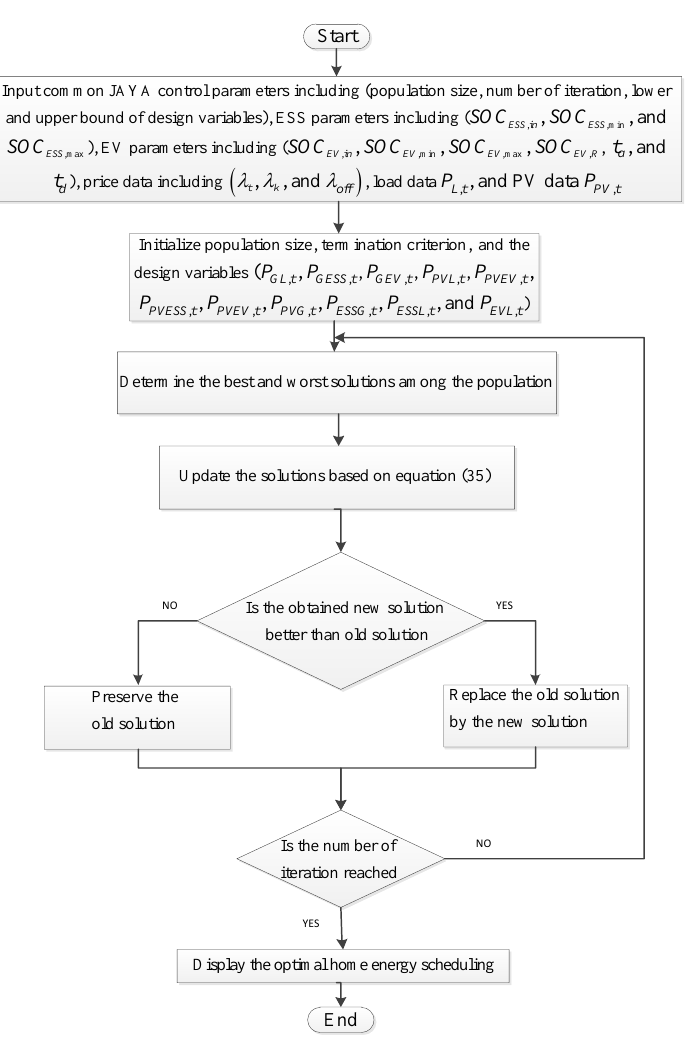
Figure 3. The flowchart of optimal energy scheduling based on Jaya